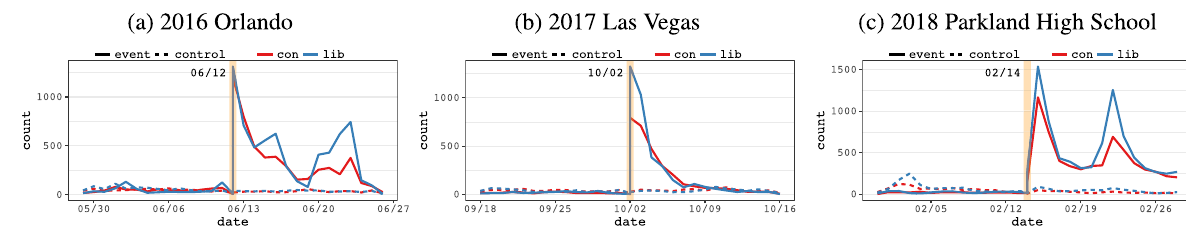
Fig. 6 Daily counts of gun-issue-relevant tweets produced by the two groups. The reference vertical line represents the date (in UTC) of both the event and its corresponding